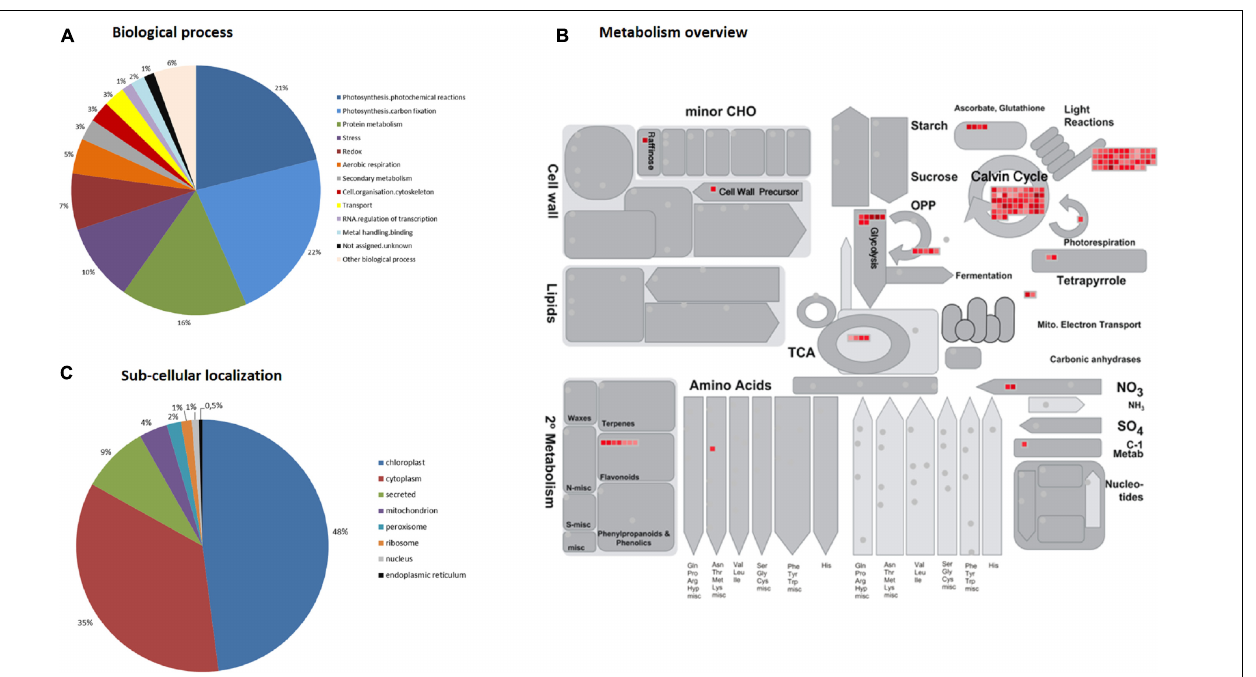
Frontiers in Plant Science |